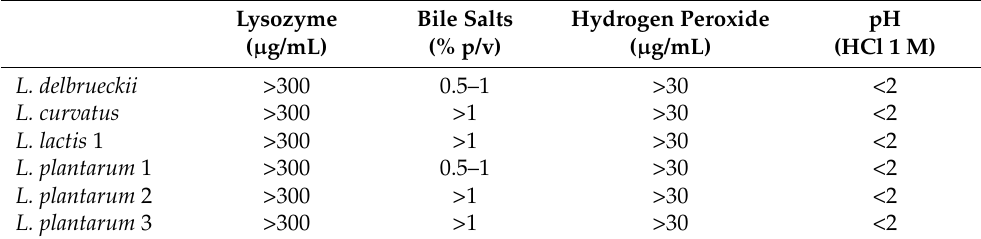
Table 5. Evaluation of microbial resistance to gastrointestinal conditions.